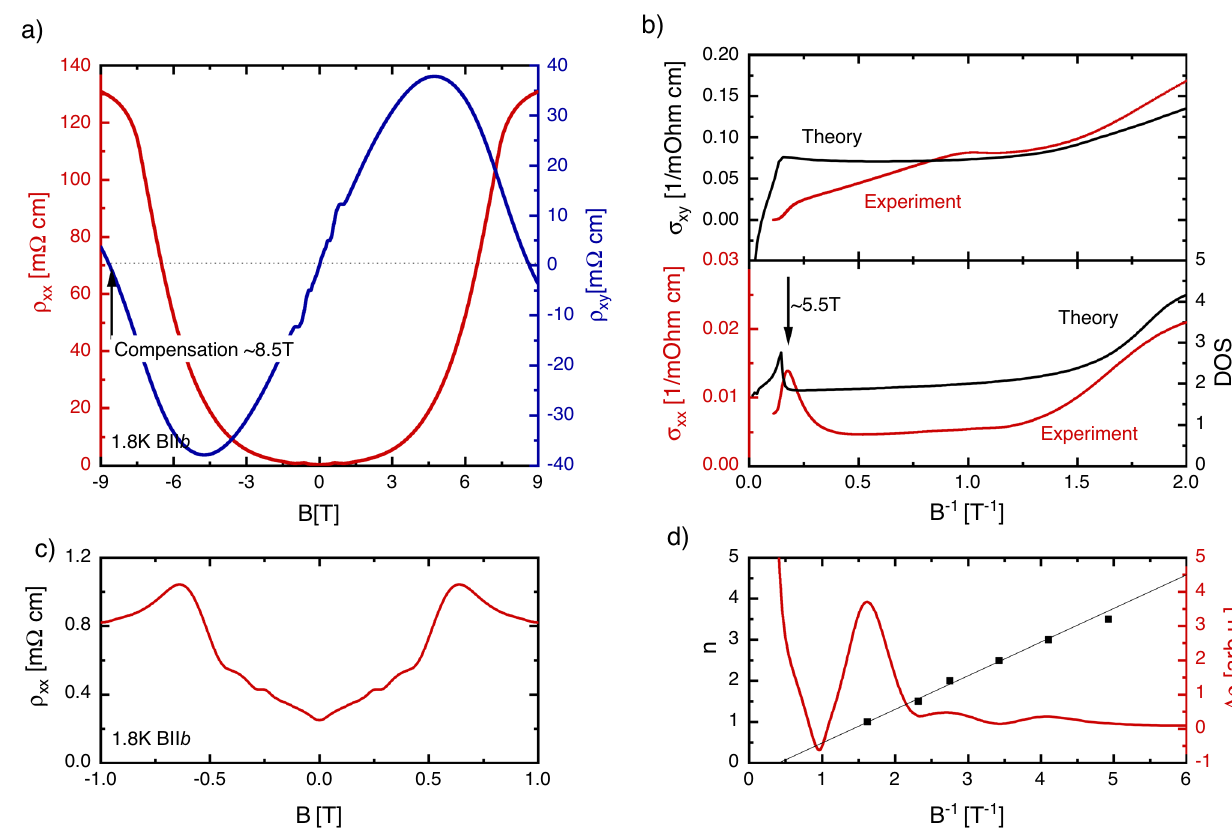
Fig. 3 | High- fi eld electrical-charge transport in ZrTe5 at 2K. a Longitudinal resistanceand Halleffect measured inSample C in staticmagnetic fi eldsat 2K,the arrow marks the point at which ρ xy =0. b Comparison of the calculated and mea- suredHallconductivityofsampleC(upperpanel)andcomparisonofthemeasured